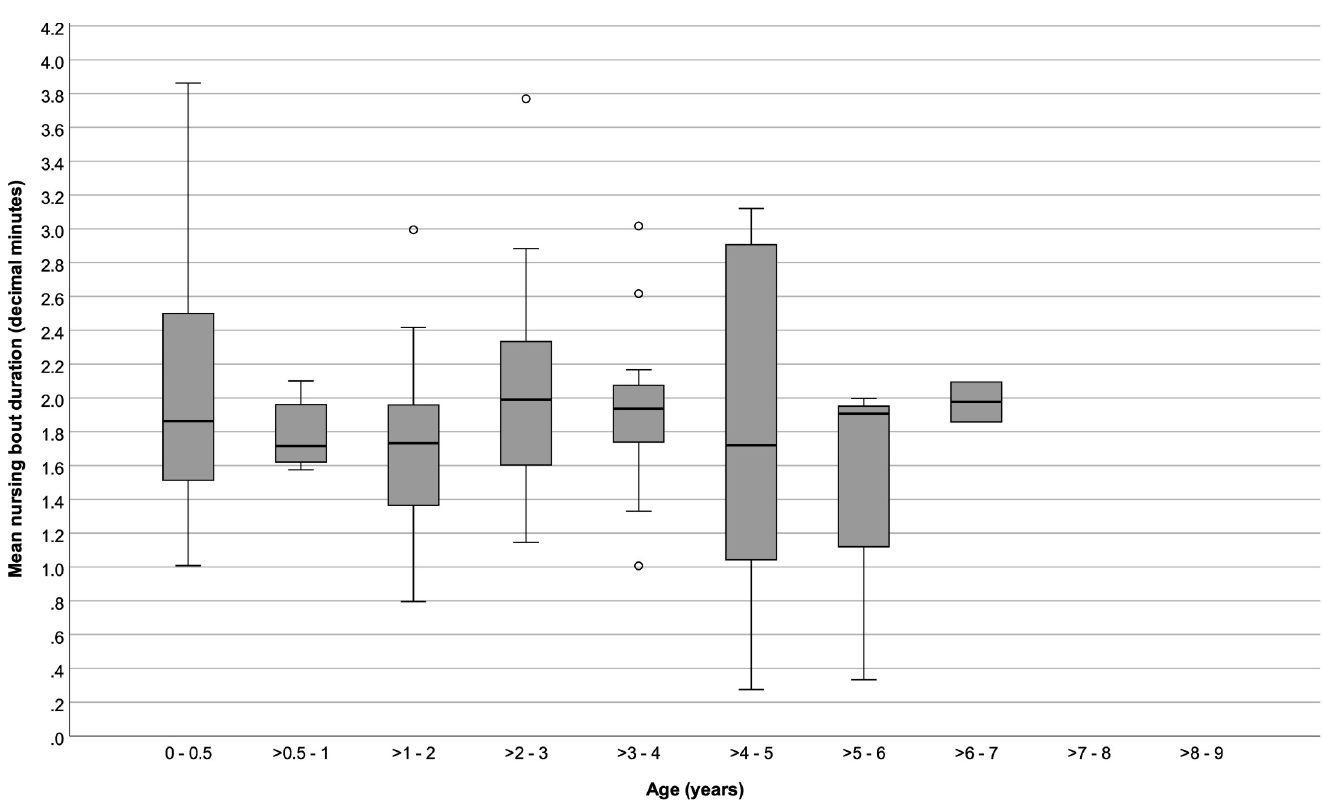
Fig 3. Average nursing bout durations of immature chimpanzees at different ages. Box plots show median values (solid horizontal lines), 25 th and 75 th percentile values (box boundaries), highest and lowest values (whiskers) and outliers (circles).